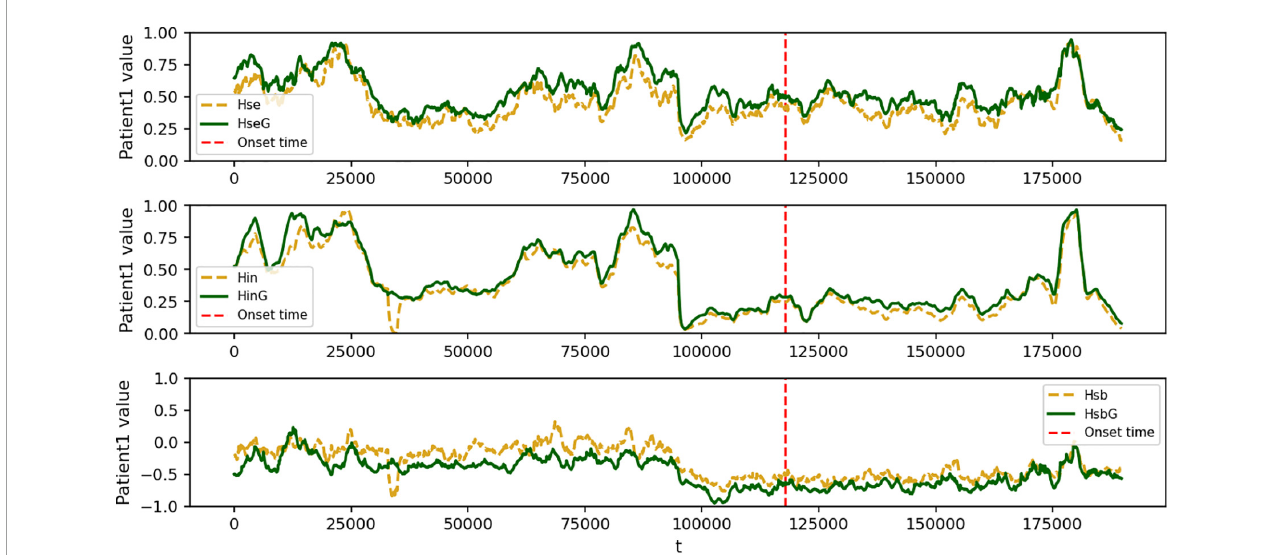
FIGURE4 Fitted curves of the change in strong local oscillations versus global slow oscillation metrics for patient 1. In each subplot, the green (yellow) curve represents the global (local) epilepsy network, the red dashed line represents the onset time, the horizontal axis represents the time series t , and the vertical axis represents the H sb size, normalized to [− 1 , 1 ] . Dramatic swings vary from those of healthy people and are modified by time. (top) the variation of patient 1’s local strong oscillations H se over time; (middle) the change of patient 1’s global slow oscillation index H in over time; and (bottom) the variation of patient 1’s sub-stable equilibrium index H sb between strong local and slow global oscillations over time.